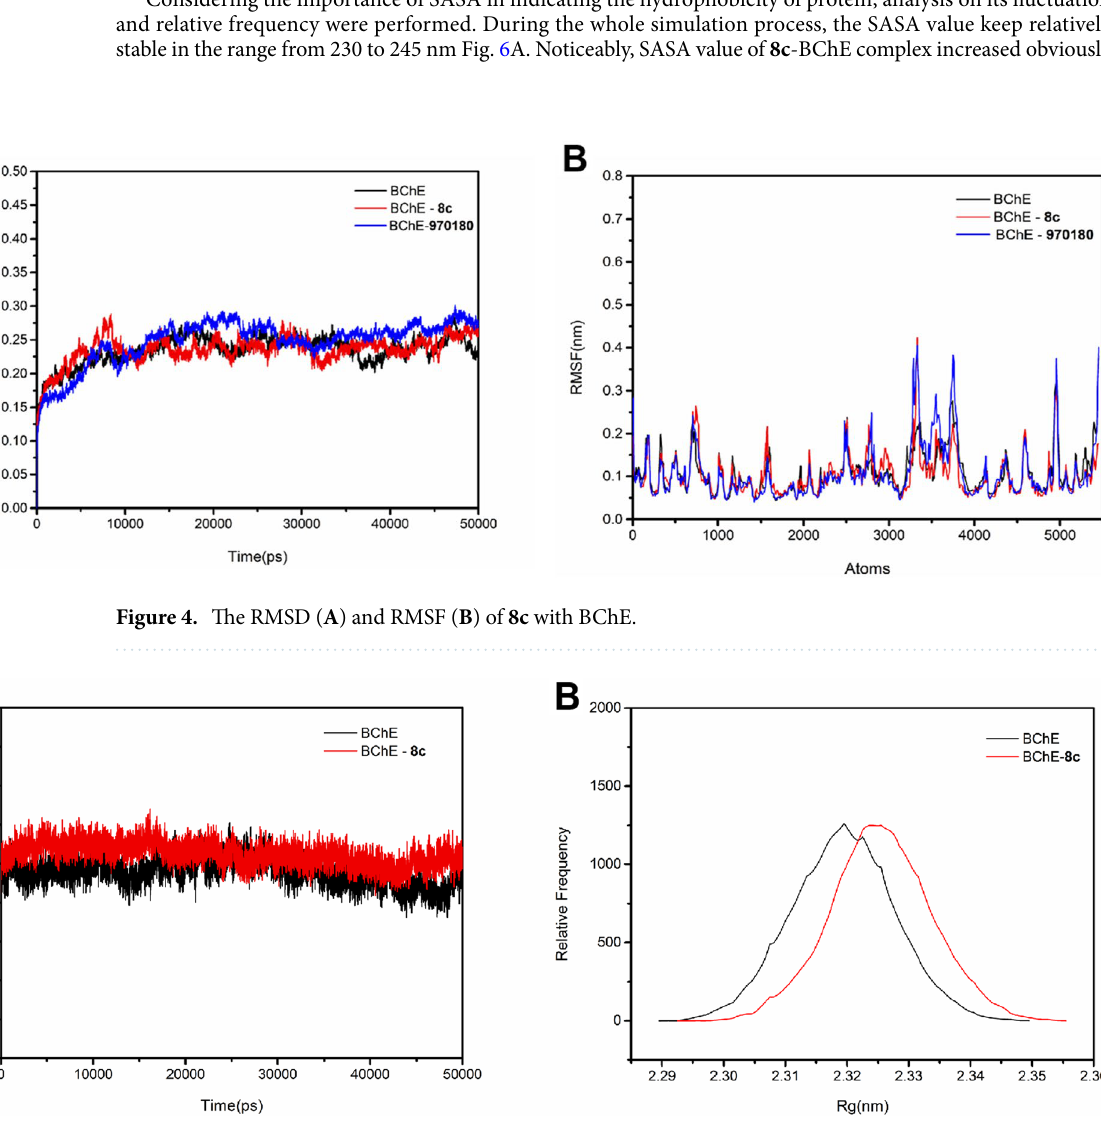
Figure 5. Changes in Rg values ( A ) and relative distribution frequency ( B ) of 8c -BChE